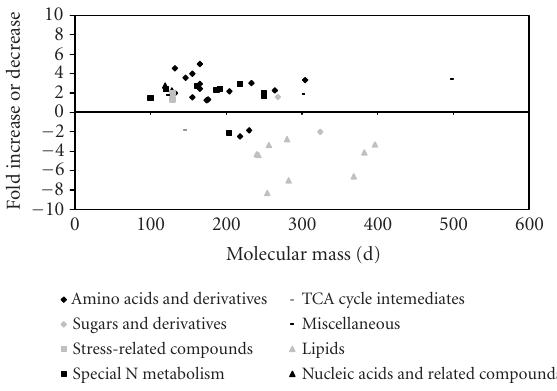
Figure 1. Distribution of metabolites (judged by mass) altered in relative abundance in leaves and roots. Grey diamonds are leaf metabolites and black triangles represent metabolites altered in roots.